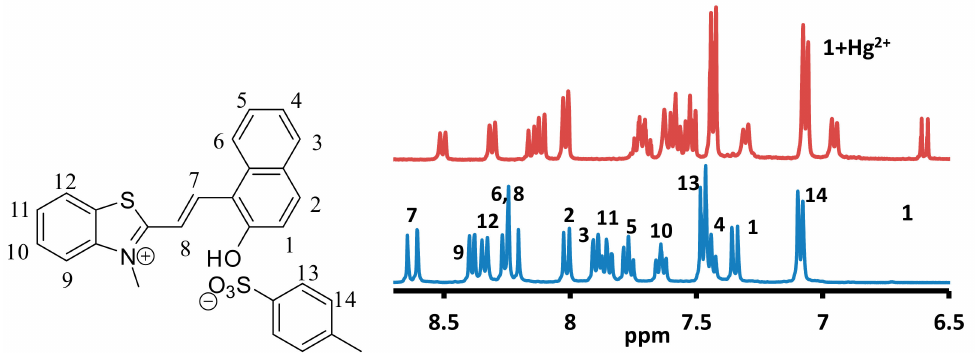
Figure 14. Partial 1 H-NMR spectra of 1 and 1 -Hg 2 + in DMSO- d 6 recorded on a 400 MHz instrument showing a comparison in the aromatic